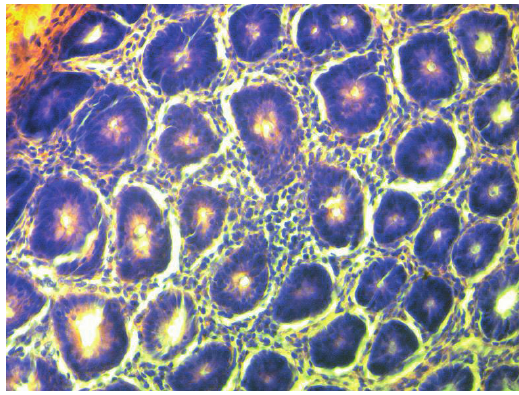
Figure 6d: Moderate dose group. 6d Moderate dose group 6d Moderate dose group